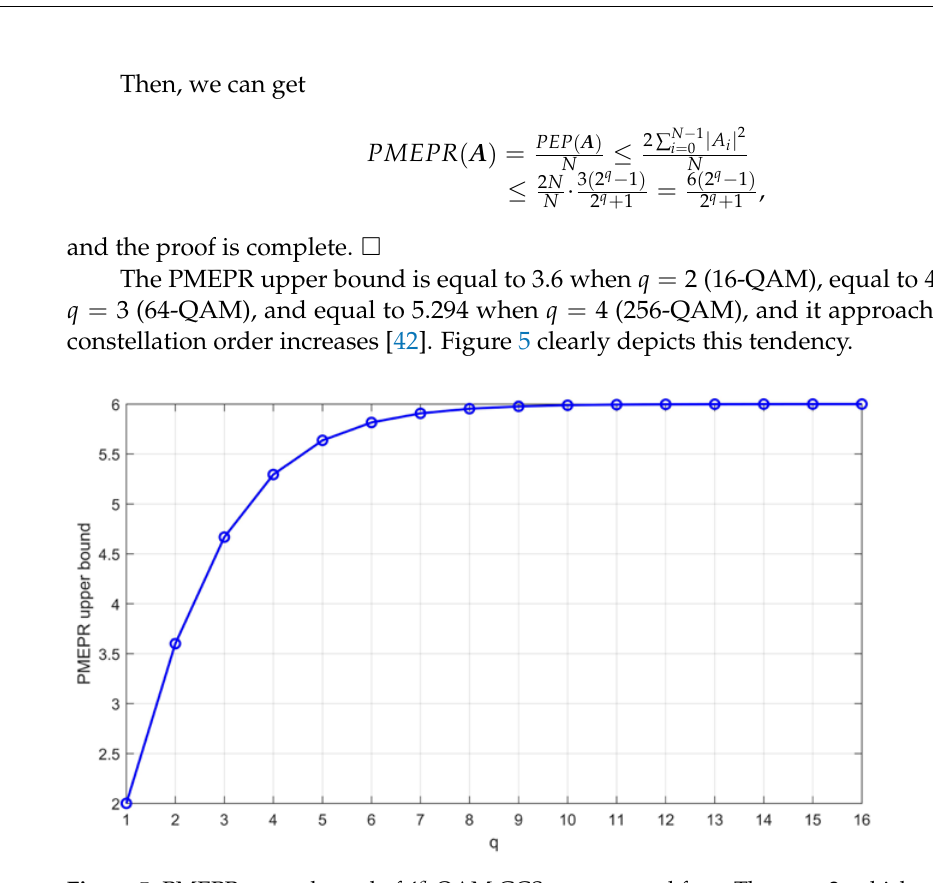
Figure 5. PMEPR upper bound of 4 q -QAM GCSs constructed from Theorem 2, which approaches 6 as q increases.